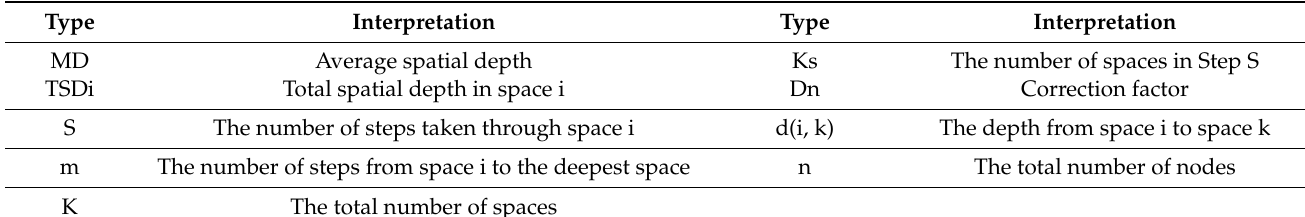
Table 2. Interpretation of space syntax expressions.